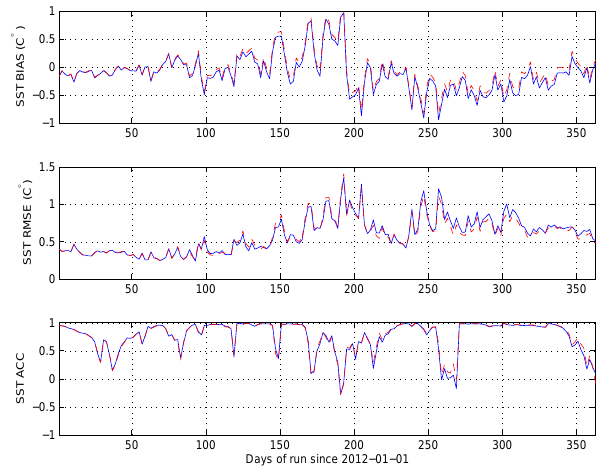
Figure 2. Top to bottom: BIAS, RMSE and ACC for BF (blue) and BFC (red dashed) experiments. Units for BIAS and RMSE are ◦ C, while ACC is